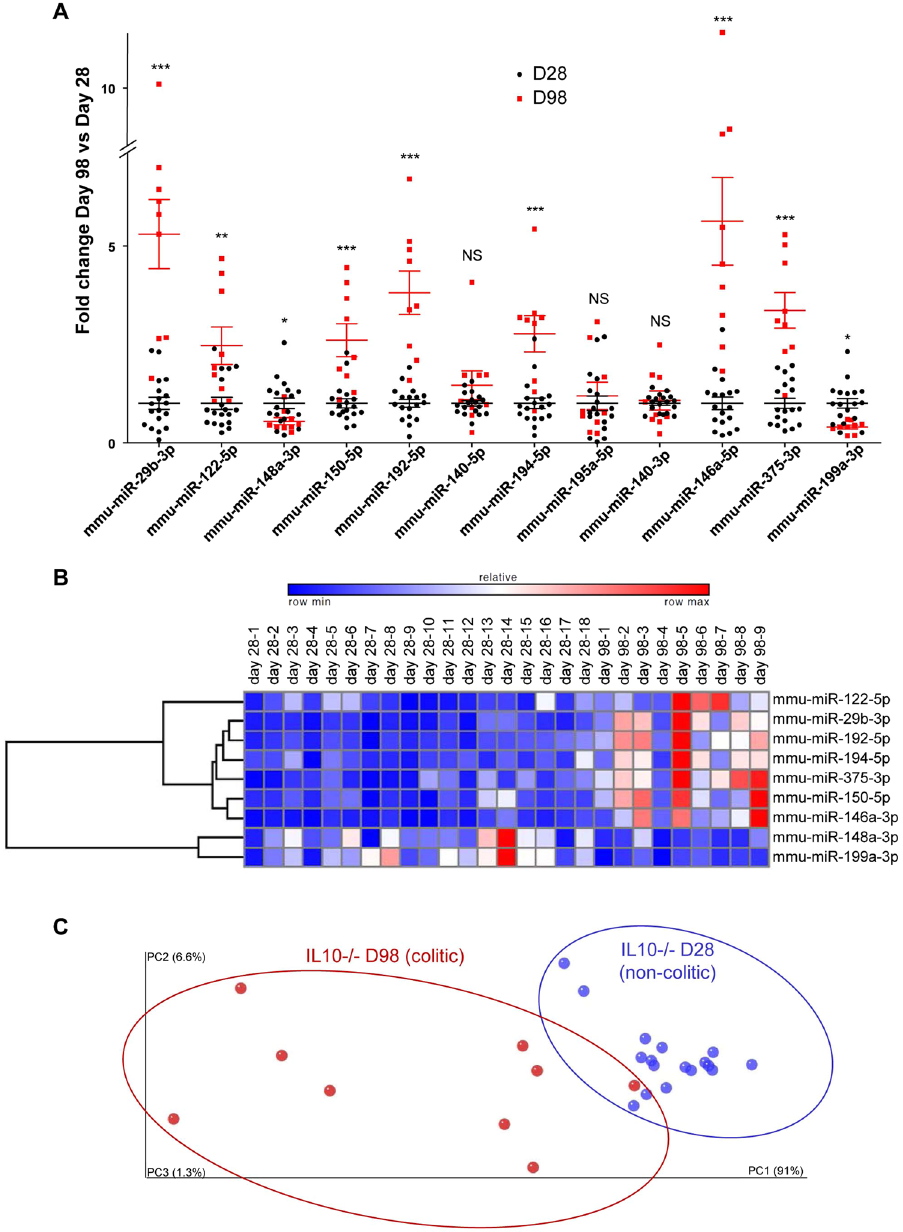
Figure 2. Validation of a new miRNA signature for the assessment of colitis in a validation cohort of IL10 − / − mice. The expression levels of 13 deregulated miRNAs were validated by qPCR using a second and independent set of IL10 − / − mice. ( A ) Fold changes of the 12 expressed miRNAs in this new set of IL10 − / − colitic mice (D98) compared to IL10 − / − non-colitic mice (D28). The expression level of each miRNA was analyzed and standardized to 1 in non-colitic mice. ( B ) Hierarchical clustering showing the relative expression levels of the nine miRNAs in each sample. ( C ) Principal coordinate analysis (PCoA) plot of the euclidean distance matrix for miRNA expression in sera was performed using QIIME software and plotted using Emperor Software. Percentages on the axes indicate the percentage of variance explained by each component. The populations of the nine selected miRNAs in 28 day-old (blue) or 98 day-old (red) IL10 − / − mice were clustered using normed PCoA. Permanova test, p = 0.001. Data are presented as the means + / − S.E.M. (n = 9–18). Significance was determined using unpaired t-test ( * p < 0.05; ** p < 0.01; *** p < 0.001; NS, not significantly different) compared to the results obtained from the corresponding D28 IL10 − / −